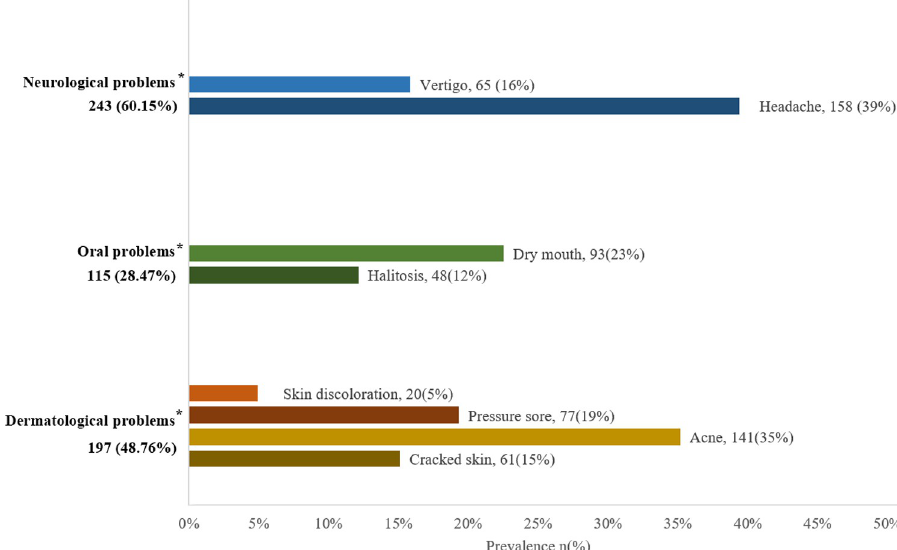
Fig 2. Types of dermatological, oral & neurological problems following face mask use (n = 404). � Multiple Responses.